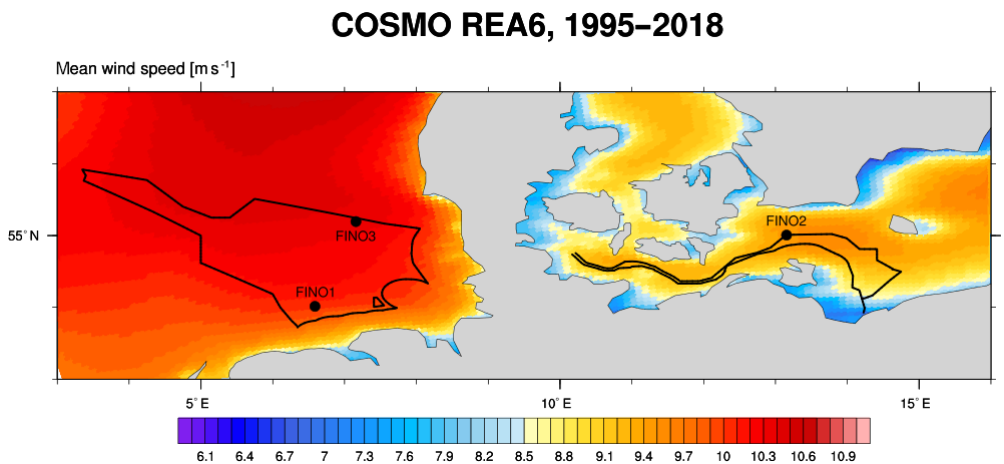
Figure 3. COSMO-REA6 average wind speed 1995–2018 in the German Exclusive Economic Zone (EEZ) in the North Sea and Baltic Sea at 116m height (level 4 of COSMO-REA6 above ground). The boundaries of the EEZ and the locations of the FINO (1, 2, 3) measurement sites are also